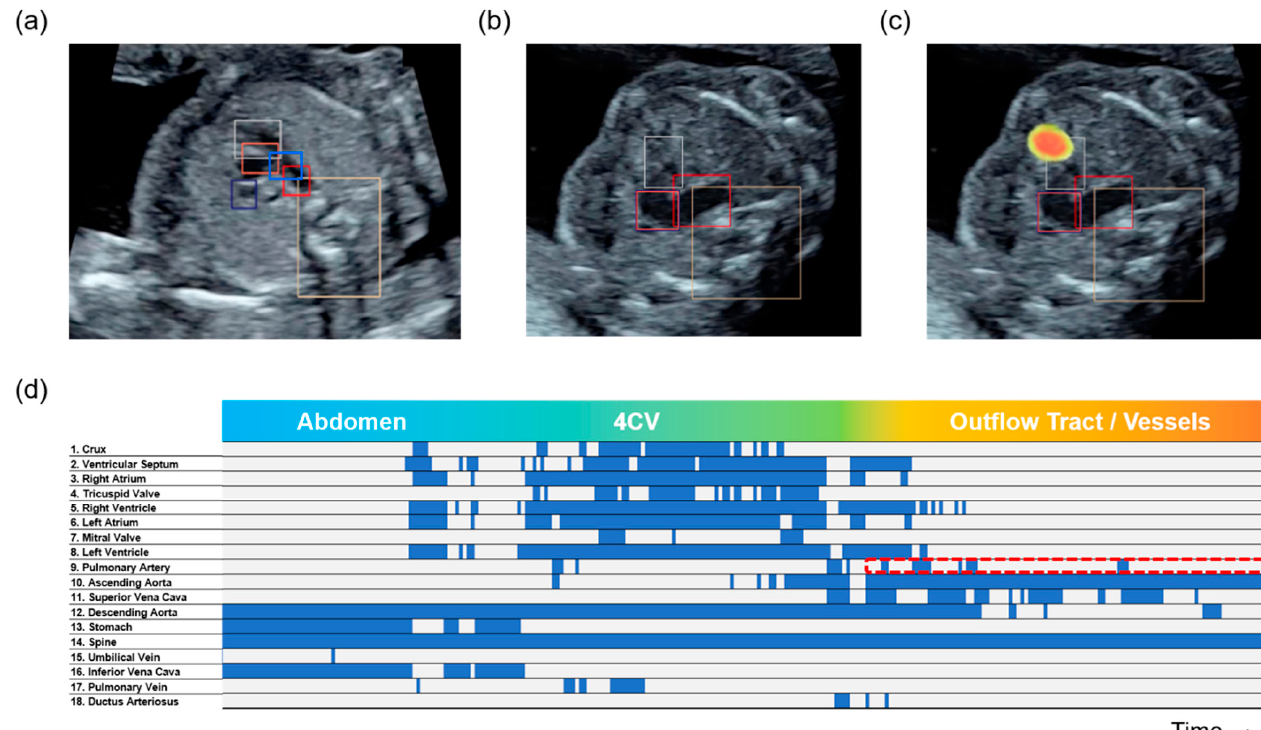
Figure 4. Possible techniques for AI explainability. The cardiac substructures were detected with colored bounding boxes in a three-vessel trachea view in ( a ) a normal case, and ( b ) a tetralogy of Fallot (TOF) case. ( c ) An image of the class-specific heatmap indicates the discriminative regions of the image that caused the particular class activity of interest. ( d ) Barcode-like timeline in a TOF case. The vertical axis represents the 18 selected substructures and the horizontal axis represents the examination timeline in the rightward direction. A probability of ≥ 0.01 was set as well-detected and is indicated as the blue bar, whereas <0.01 was set as non-detected and is indicated by the gray bar in each frame. The pulmonary artery was not detected (red dotted box).